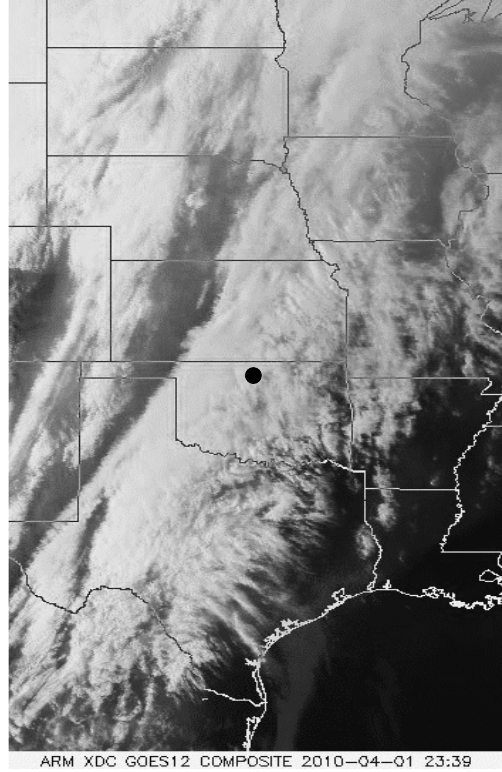
Figure 1. GOES composite image at 23:39UTC on 1 April 2010. Black circle indicates the Southern Great Plains long-term measure- ment site in